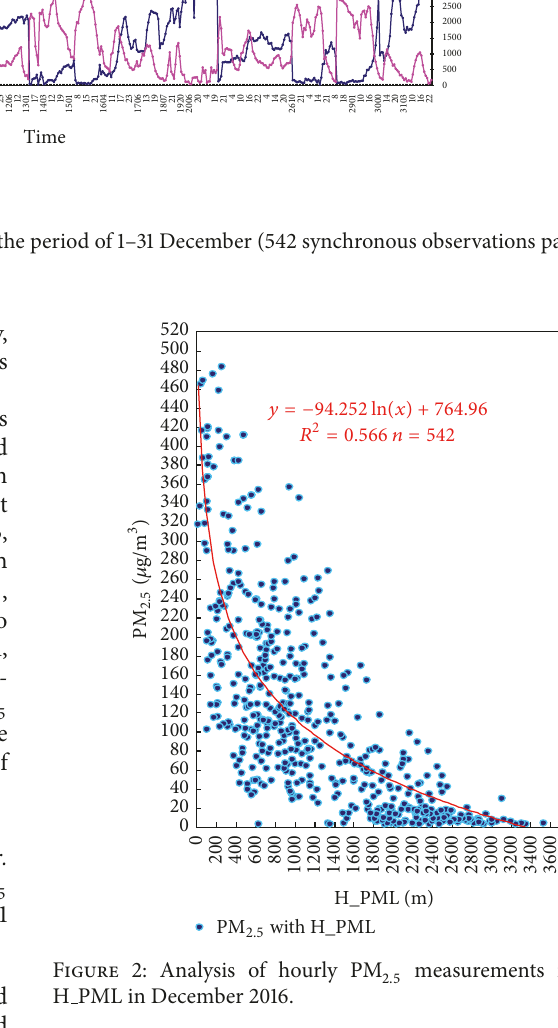
Figure 2: Analysis of hourly PM 2.5 measurements relative to H PML in December